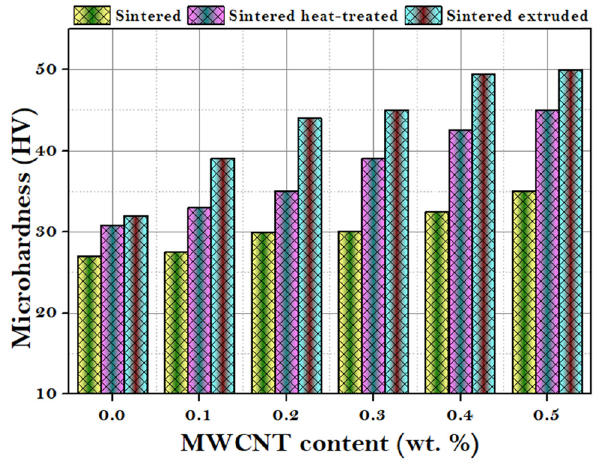
Figure 8: Microhardness of sintered, sintered - heat treated, and sintered - extruded samples plotted against wt% of AA2024 - T351 + MWCNT composites.